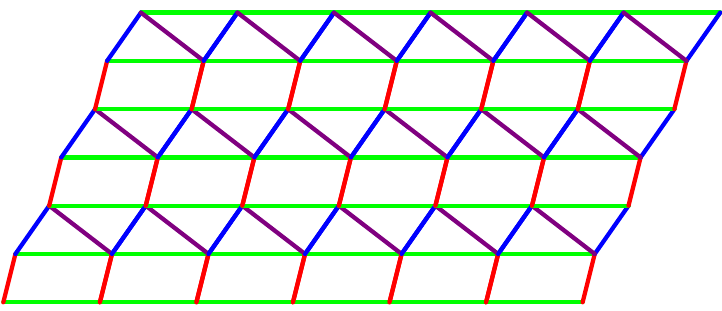
Fig. 19: Tiling with two equal parallelograms and three equal triangles (D).